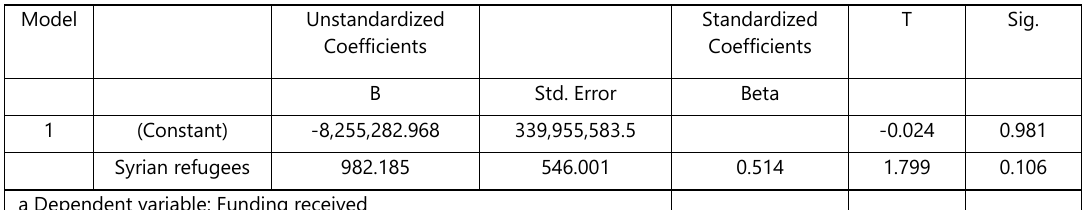
Table 5: Coefficient analysis (Source: Author‘s research 2022)